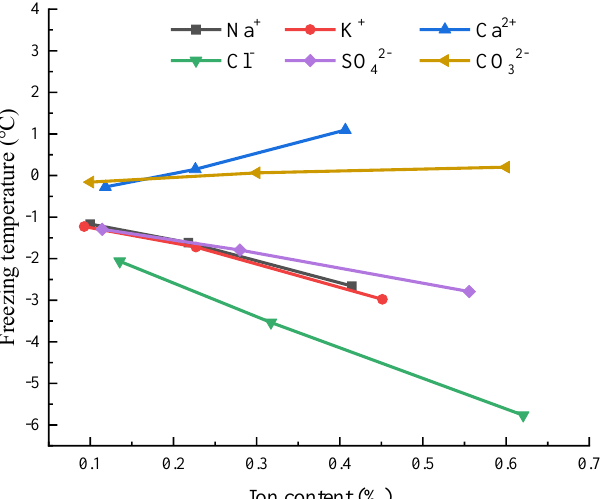
Figure 7. The relationship between freezing temperature and the content of each ion under 10% water content.